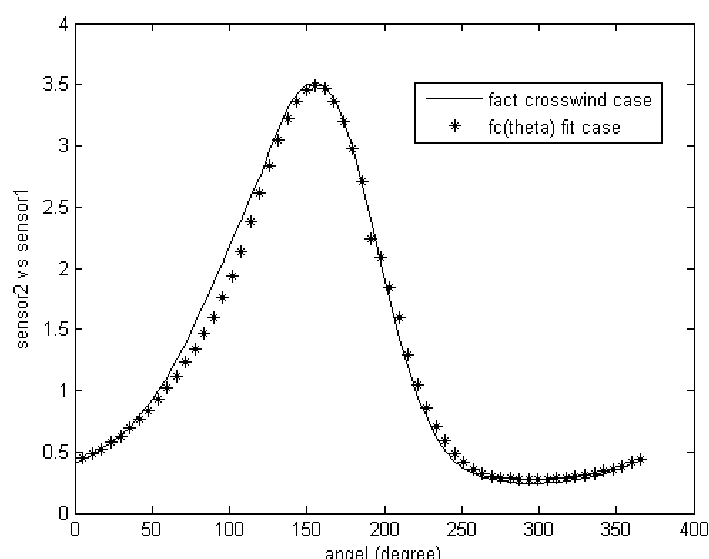
Figure 6 . Comparison of